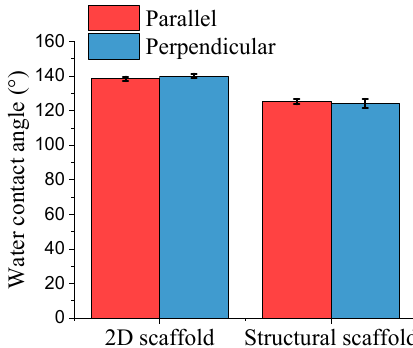
Figure 4. Water contact angles of different morphologies of polycaprolactone (PCL) scaffolds.